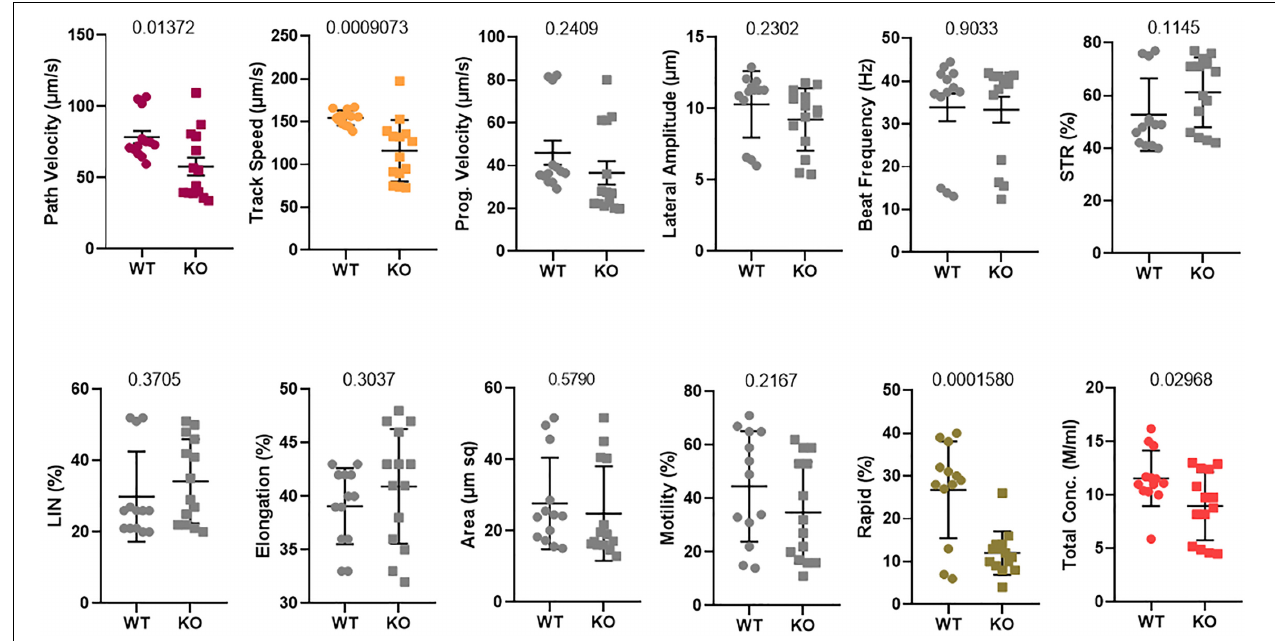
FIGURE 3 | Sperm motility was analyzed using a computer-assisted sperm analysis (CASA) system. Twelve different parameters were assayed and compared between WT and Tex13a_KO mice. p -value was displayed above each